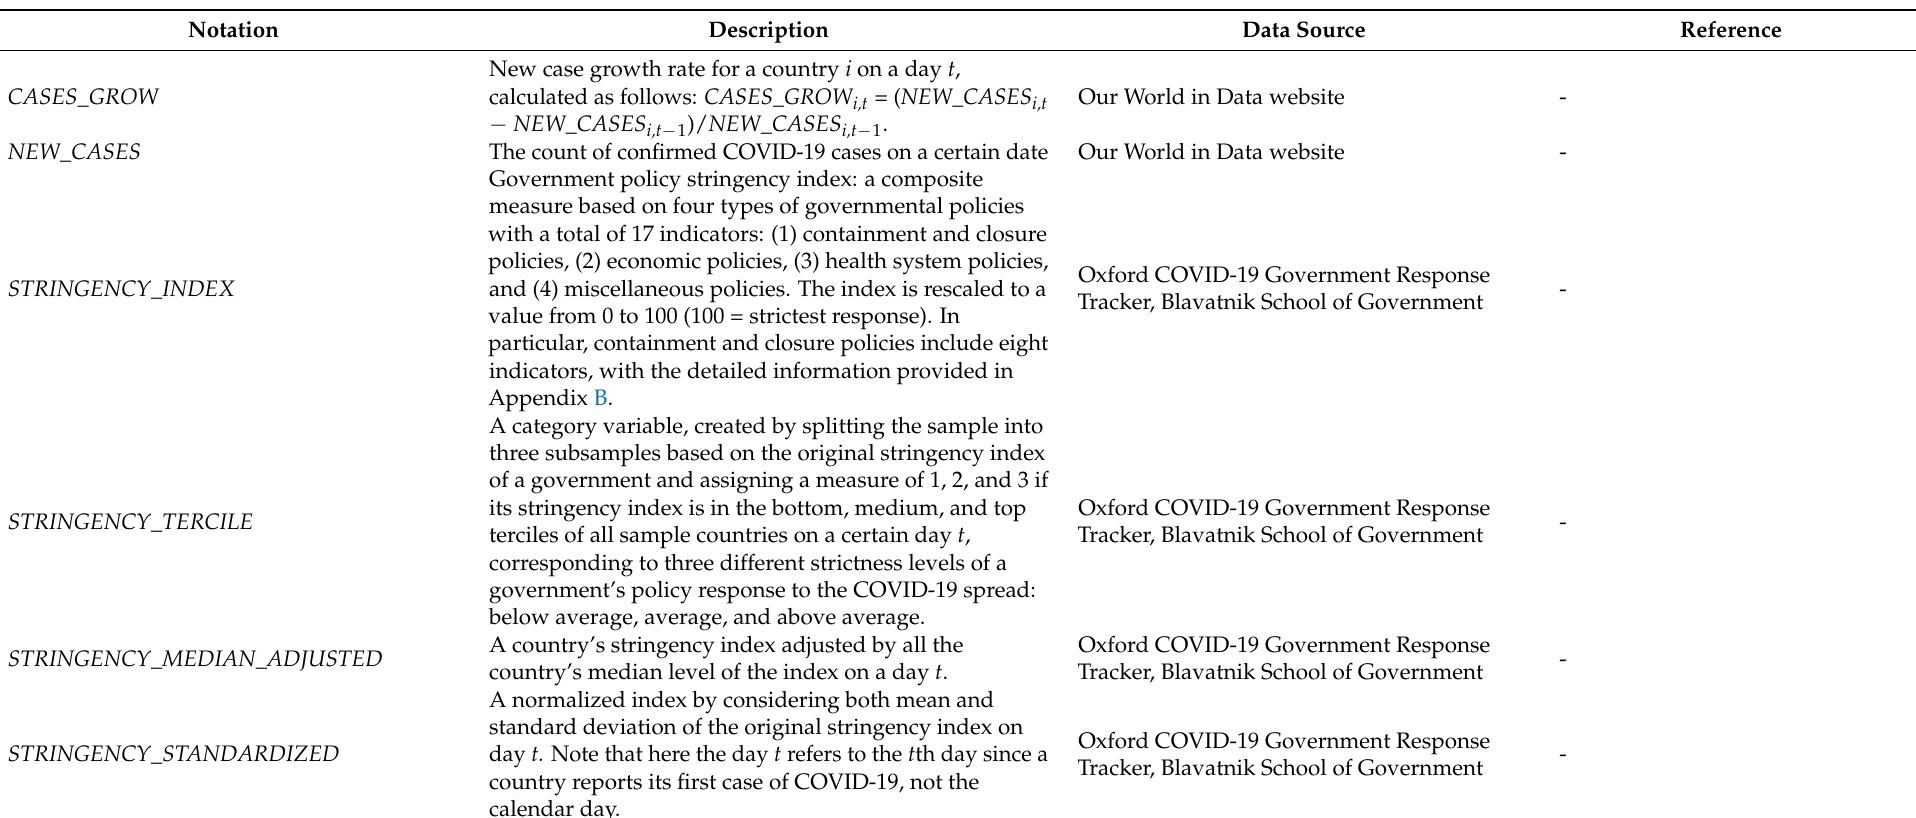
Table A1. Variable definitions, data sources, and